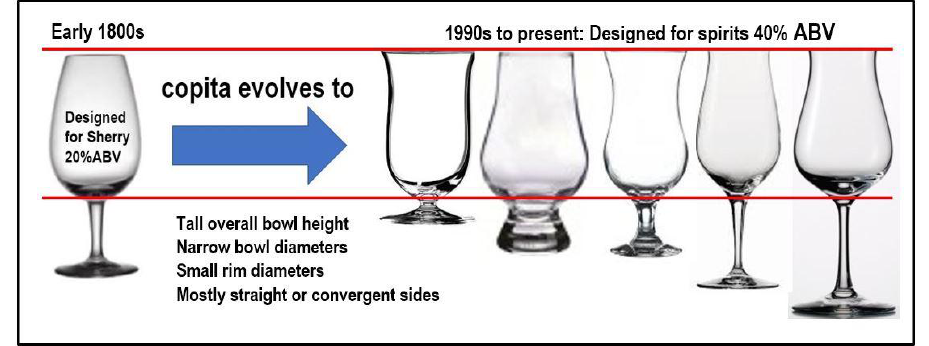
Figure 1. The copita becomes the chosen standard. The copita is a centuries-old trade tool for verifying quality by purchasing agents at loading piers and was nicknamed the “dock glass”. Similar small rim diameters, tall rim heights, and narrow bowl diameters in later designs exemplify the reluctance of vessel manufacturers to stray from the established traditional and visual identity.